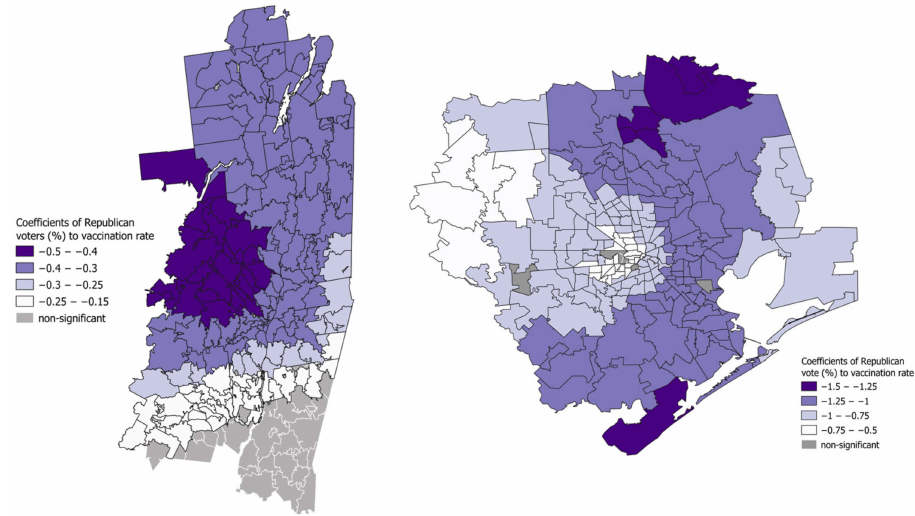
Figure 6. Local coefficients of voters for the Republican presidential candidate in 2020 (%) with regard to vaccination rates using geographically weighted regression